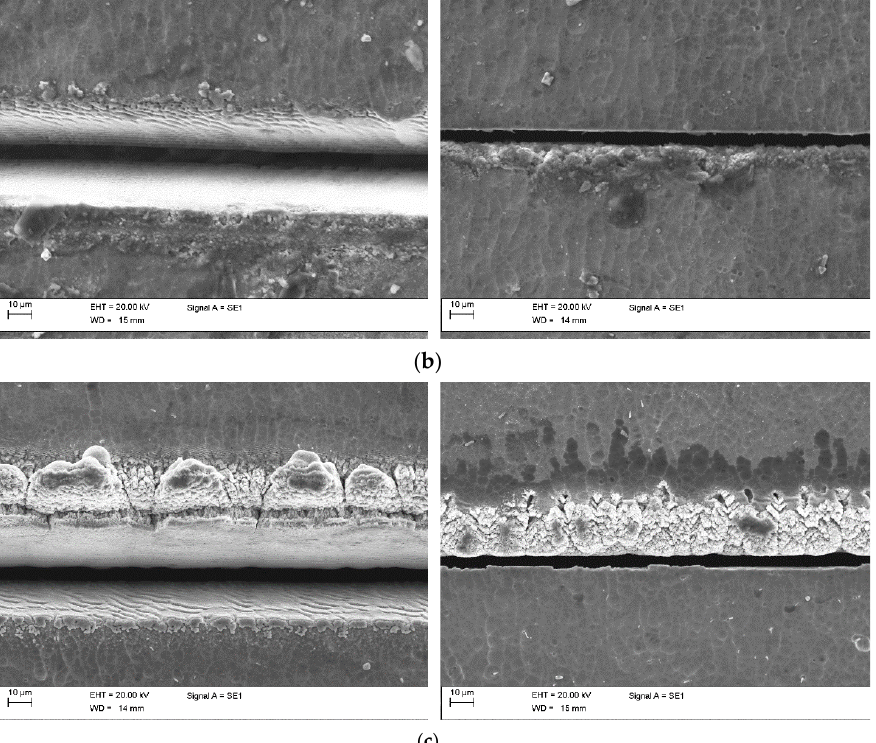
Figure 2. SEM images of the entry and exit kerfs produced with different process conditions: ( a ) P = 10 W;